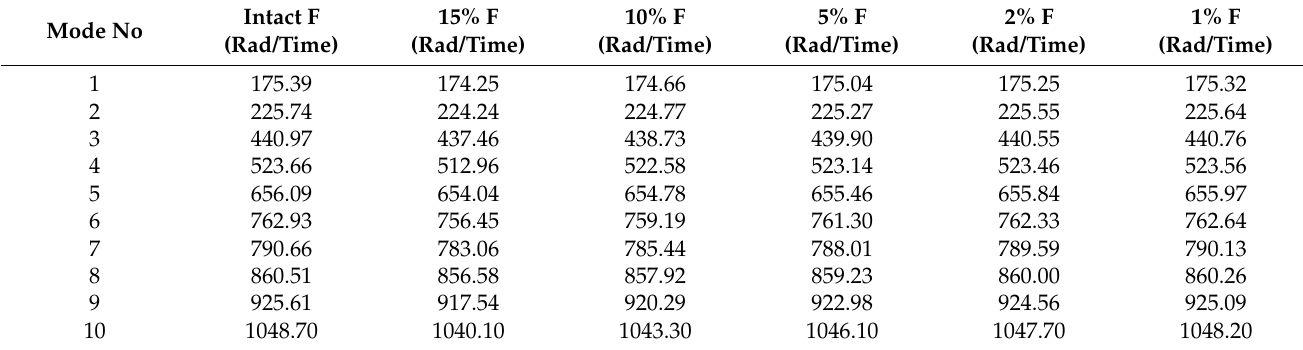
Table 5. The first ten order frequencies of the intact and damaged